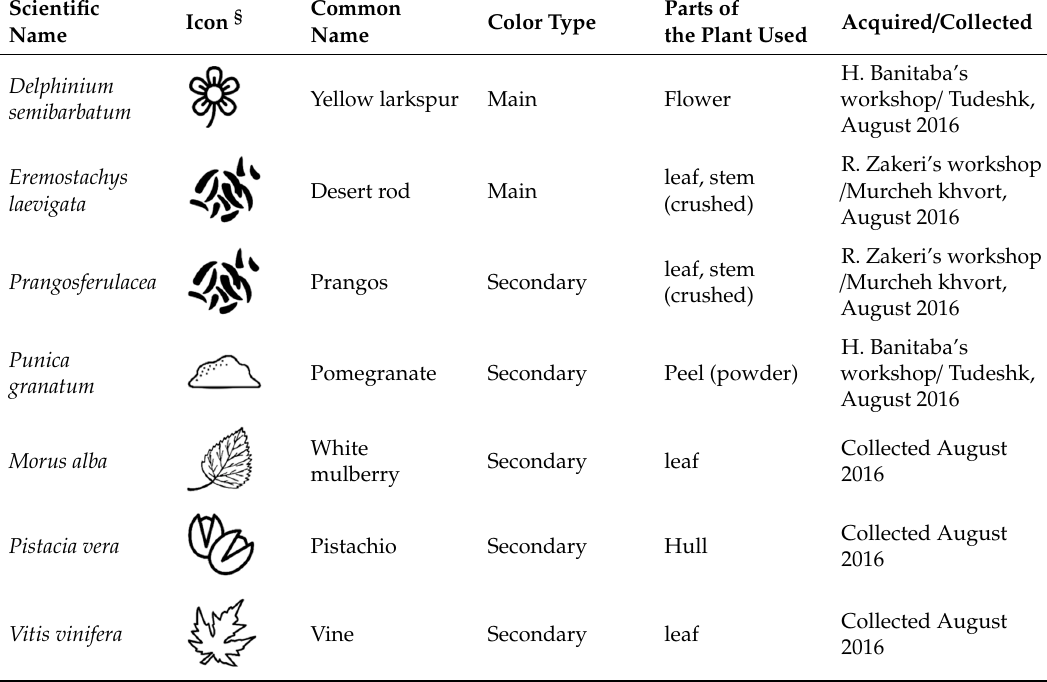
Table 3. Plant sources and parts used to dye yellow in Isfahan workshops, together with the place and date of their acquisition. Prangos may be used as main yellow in other regions of Iran.